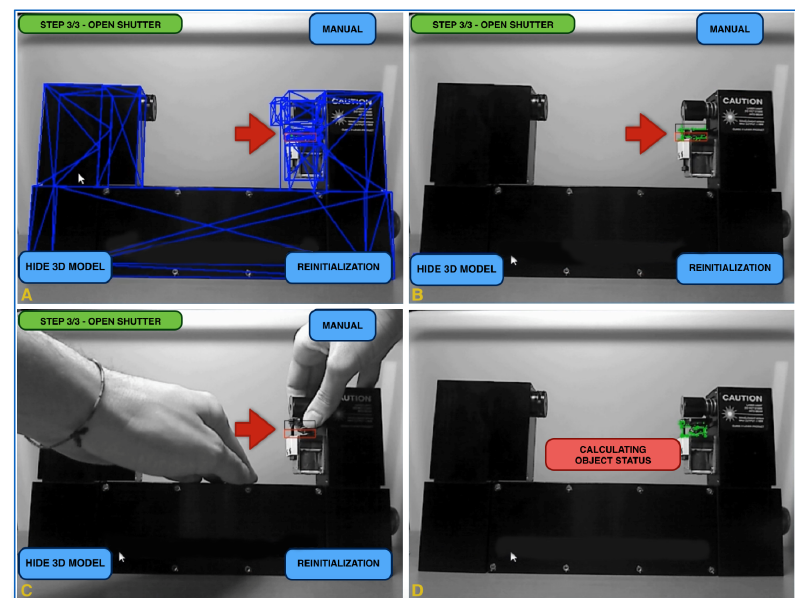
Figure 17. Industrial laser calibrator’s shutters displacement. The object status is calculated ( A ), the instruction provided to the user ( B ), the user remove the external cover ( C ) and then the system computes the object status again ( C